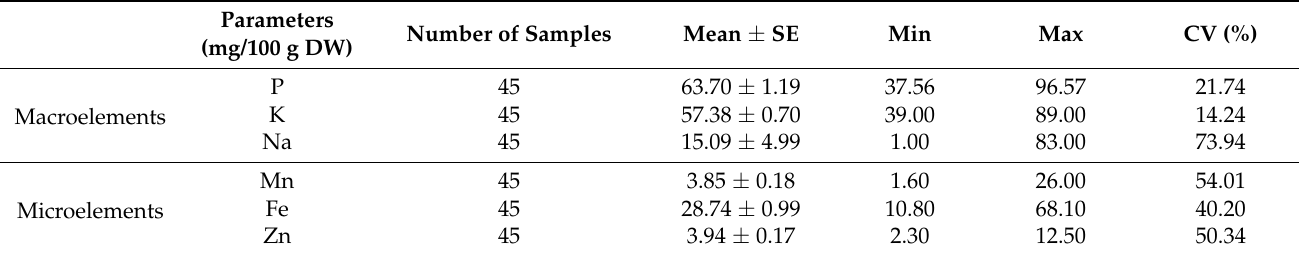
Table 3. The average value of macro and microelements in the mineral composition of Moroccan A. unedo